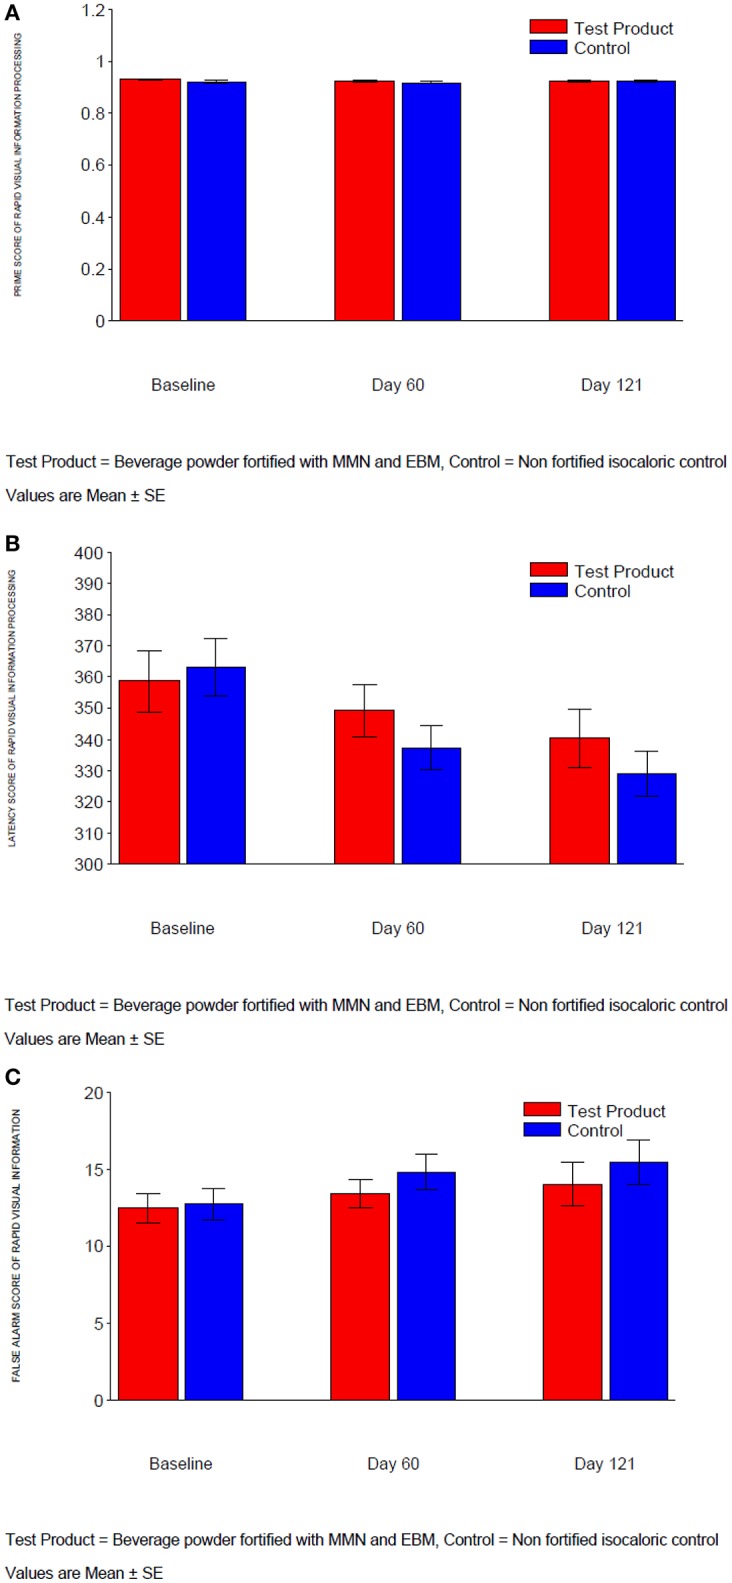
(A) Prime score of rapid visual information processing. (B) Latency of rapid visual information processing. (C) False alarm of rapid visual information processing.